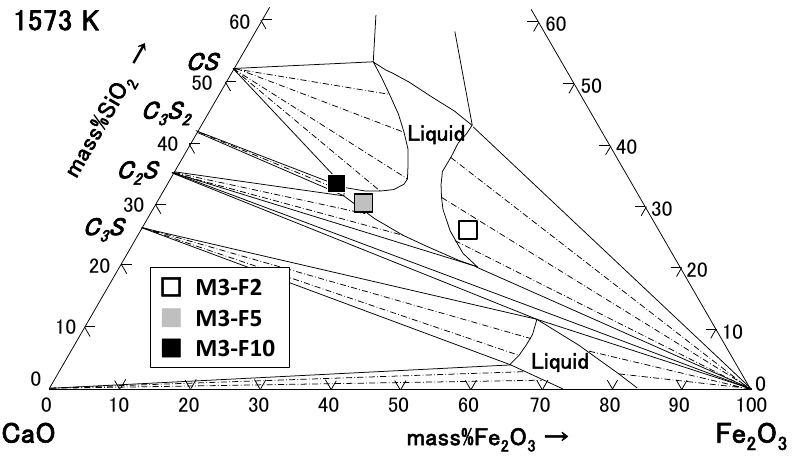
Figure 14. Composition of the observed phases in the quaternary samples containing Fe 2 O 3 projected on a CaO-SiO 2 -Fe 2 O 3 diagram.